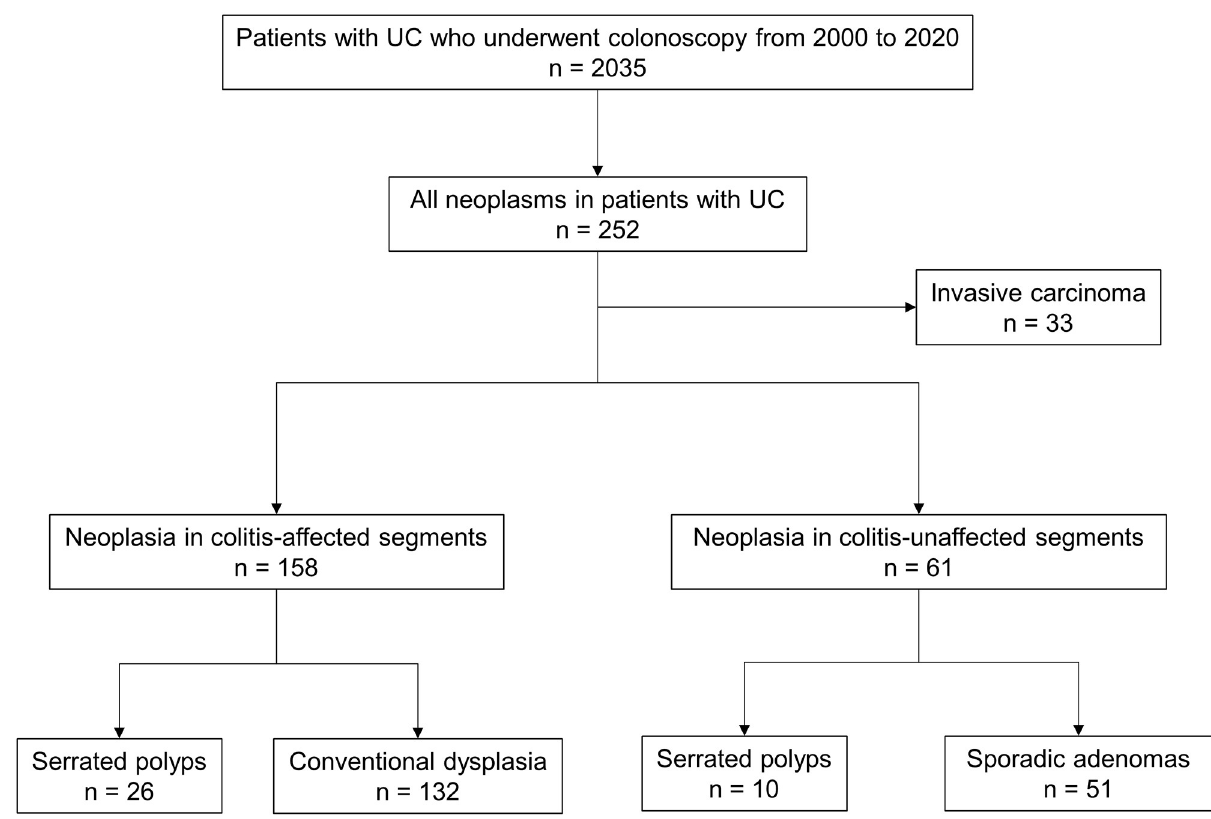
Fig 1. Overview of the cohort in the present study. In total, 252 neoplasms were detected in 2035 patients with UC who underwent total colonoscopy during the study period: 158 neoplasms in colitis-affected segments (26 serrated polyps and 132 cases of conventional dysplasia), 61 neoplasms in colitis-unaffected segments (10 serrated polyps and 51 sporadic adenomas), and 33 invasive carcinomas. UC, ulcerative